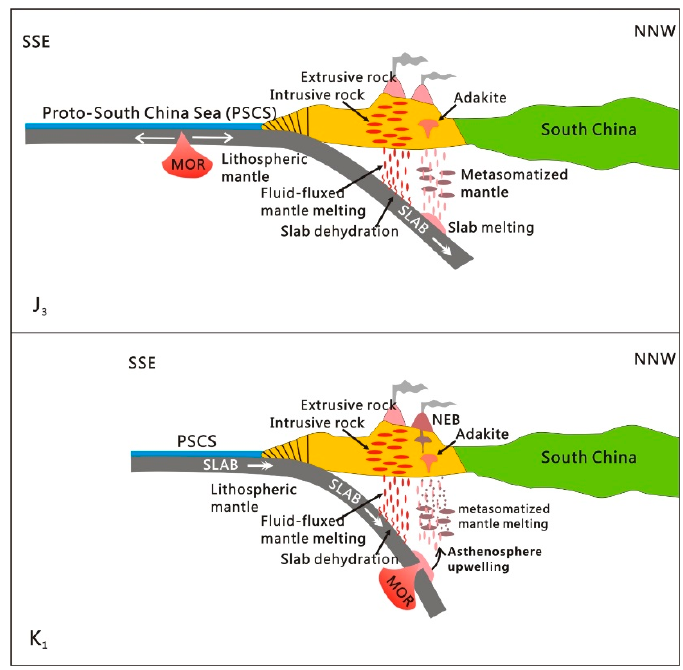
Figure 13. Schematic tectonic model of SE Asia during the Late Mesozoic illustrating the generation of the NEBs, adakites, and arc magmatic rocks in the SCS. During the Late Jurassic (J 3 ), the young, and thus hot, subducted oceanic lithosphere of the PSCS was dehydrated at a relatively shallow depth, which triggered fluid ‐ fluxed partial melting of the overlying mantle wedge, producing the early arc magmatic rocks. With further subduction, the PSCS slab underwent partial melting at depth and generated the early adakites and metasomatized mantle with Nb ‐ enriched minerals. During the Early Cretaceous (K 1 ), the mid ‐ oceanic ridge (MOR) was subducted, and subsequently, the subducted slab broke off, leading to asthenospheric upwelling. Heat derived from the upwelling not only induced partial melting of the broken slab at its edge and of the early metasomatized mantle to form the late adakites and NEBs, respectively, but also resulted in a second dehydration event of the broken slab, far from the edge. The fluids from this second dehydration phase triggered a subsequent partial melting of the overlying mantle wedge and generated the late arc ‐ related magmatic rocks.